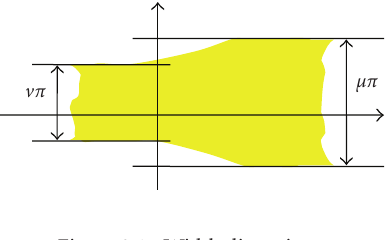
Figure 3.1. Width